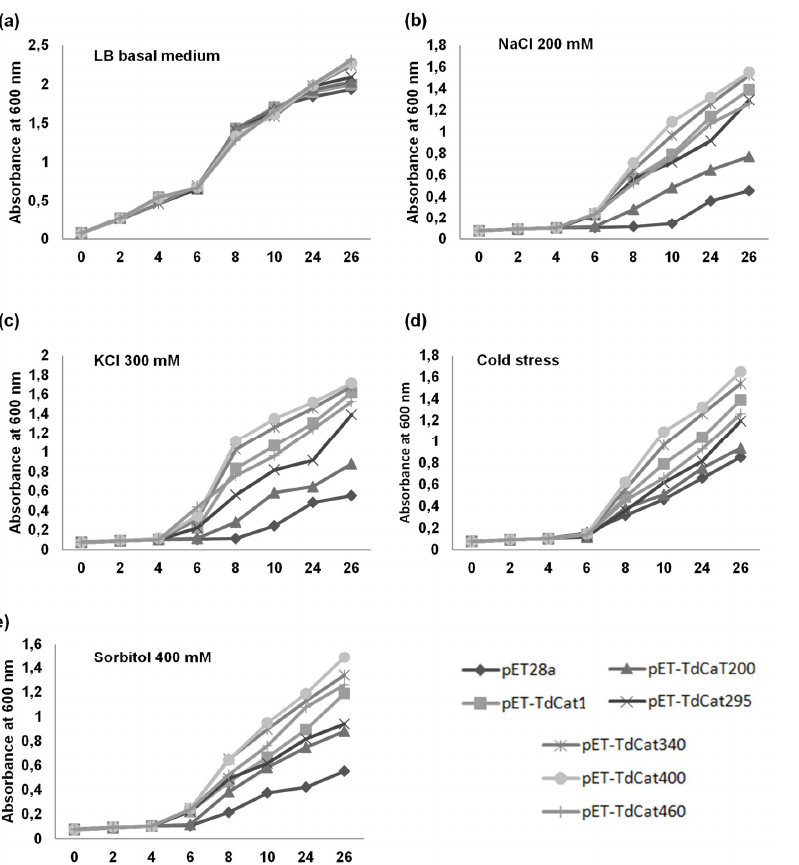
Figure 4. Behavior of TdCAT1 and derivative-forms-transformed bacteria in liquid LB medium in the presence or absence of abiotic stress. E. coli cells transformed with the empty vector (pET28a) or with the recombinant vectors (pET28a + TdCAT1 or its derivatives) were grown for 24 h under normal growth conditions (LB medium) ( a ) or after the addition of 200 mM NaCl ( b ), 200 mM KCl ( c ), 10 mM CaCl 2 ( d ), cold stress (4 °C) ( e ), or 400 mM Sorbitol ( f ). Data are means ± SE of three biological replicates.